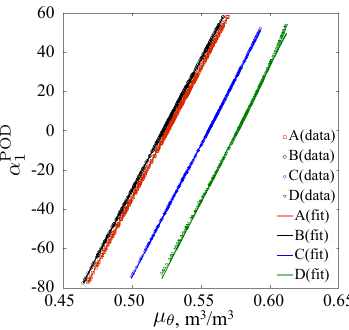
Figure 6. The variation of mean POD-MM error ( ¯ e POD - MM respect to M for different 1x g at sites A and D in 2006. Results are shown for single-site ROM constructed using POD-MM method.